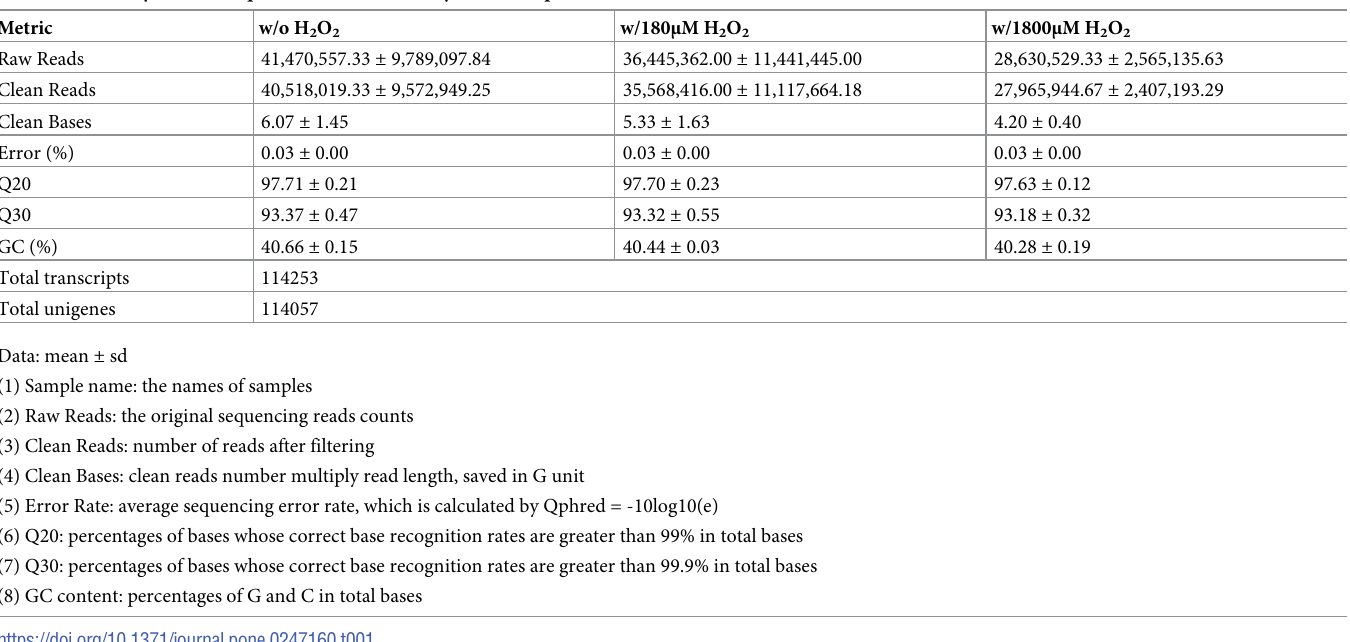
Table 1. Summary of RNA-seq metrics from Aremia cysts